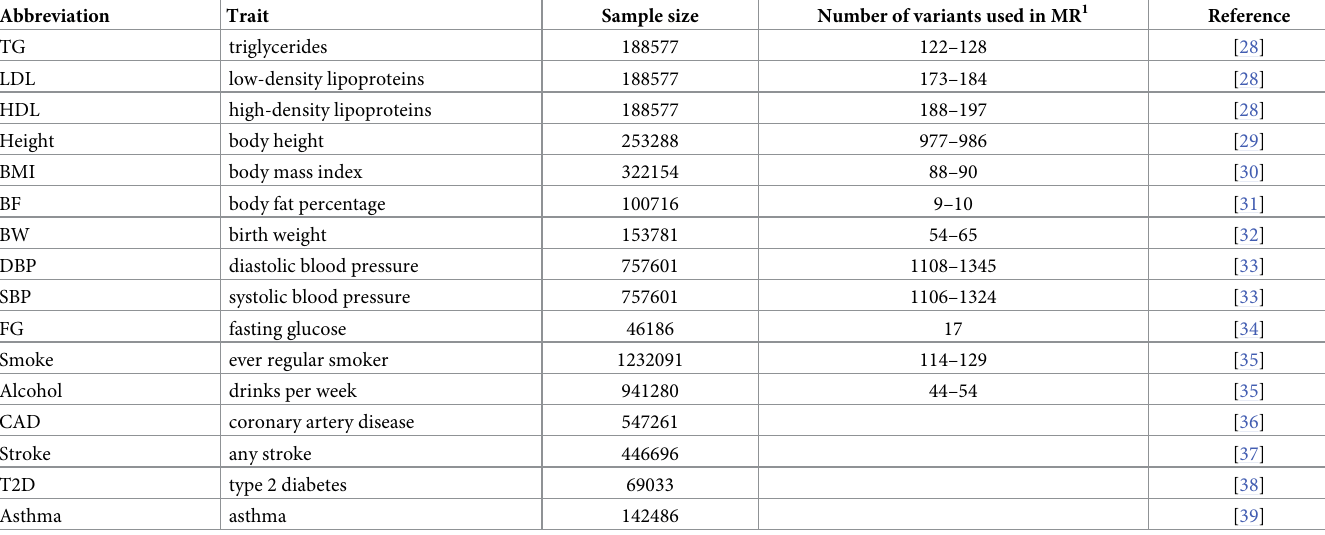
Table 1. Genome wide association studies for 4 common diseases and 12 risk